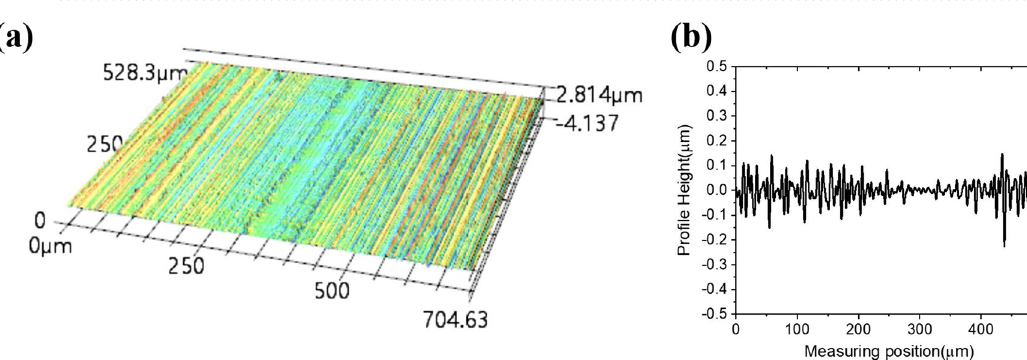
Figure 11. Confocal laser microscope measuring results of the PMMA surface after removing the overflowed conductive ink with the planing process. ( a ) 3D image of the PMMA surface after removing the overfilled conductive ink, ( b ) roughness profile of the PMMA surface after removing the overflowed conductive ink.